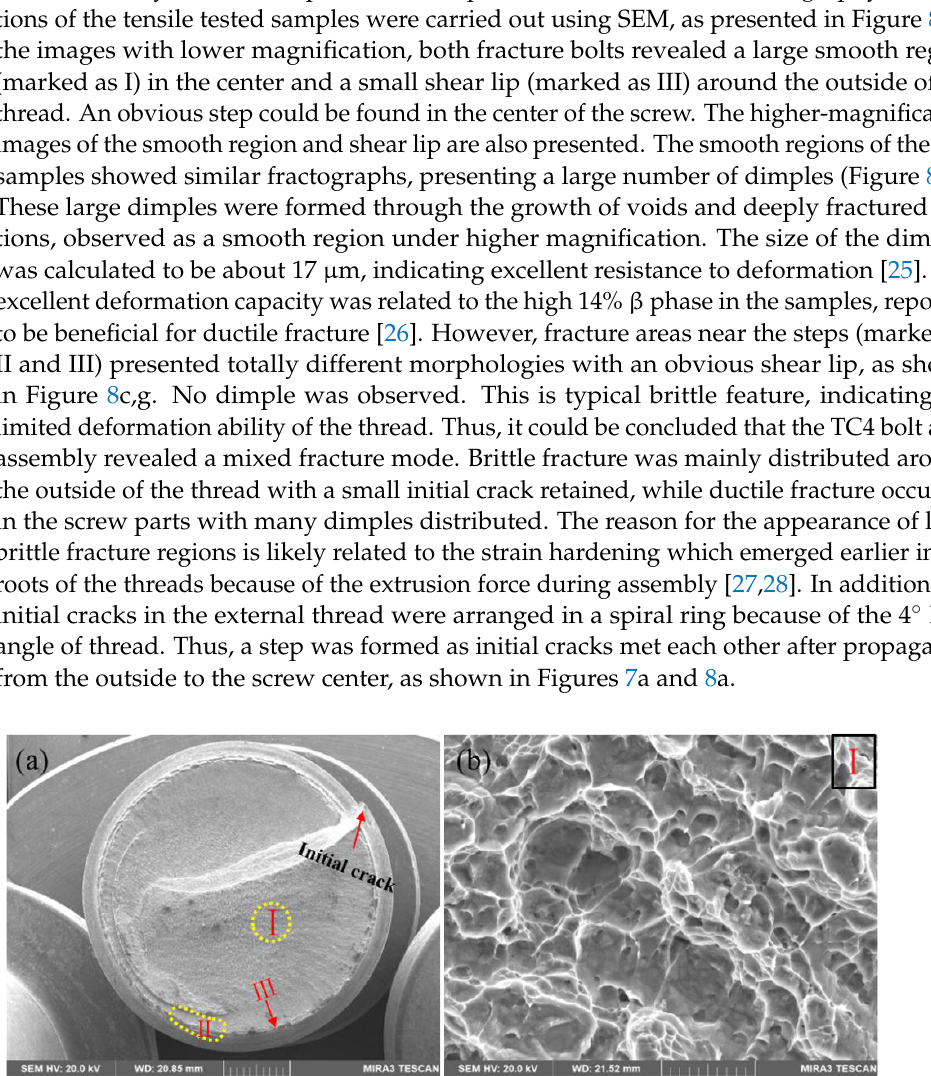
Figure 8. Fracture morphology of tensile samples: ( a – d ) for sample 1; ( e – h ) for sample 2. 3.5. Fracture Mode of the Assembly Bolt under Tensile Load Titanium alloy Ti6Al4V is a two-phase alloy which possesses good plasticity due to the spring back property and hcp crystal structure of the micro- constituent ‘α’ phase. For